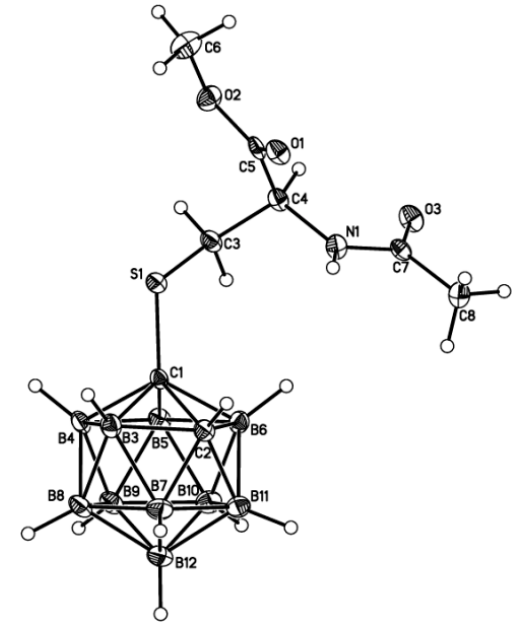
Figure 2. General view of the molecule 8 in crystal. Non-hydrogen atoms are given as probability ellipsoids of atomic displacements ( p = 0.5).